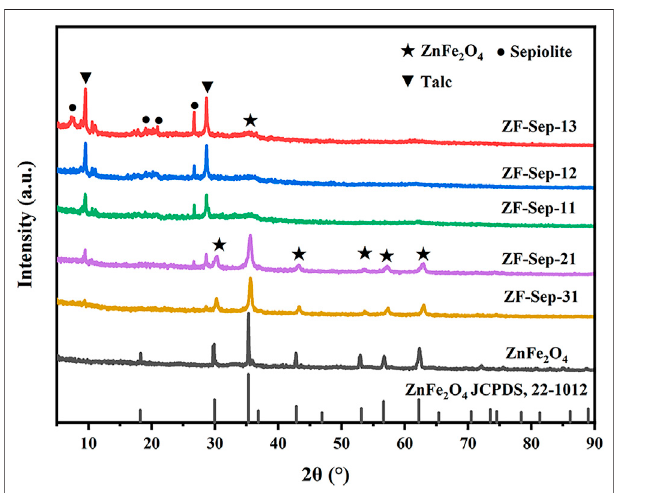
FIGURE 4 | FT-IR spectra of ZnFe 2 O 4 , Sepiolite and